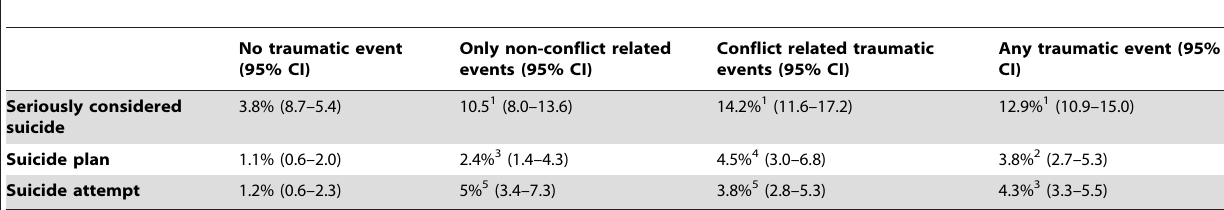
Table 3. Proportions endorsing suicidal ideation, plans and attempt among those with no traumatic event, only non-conflict related traumatic events, conflict-related traumatic events and any traumatic event.